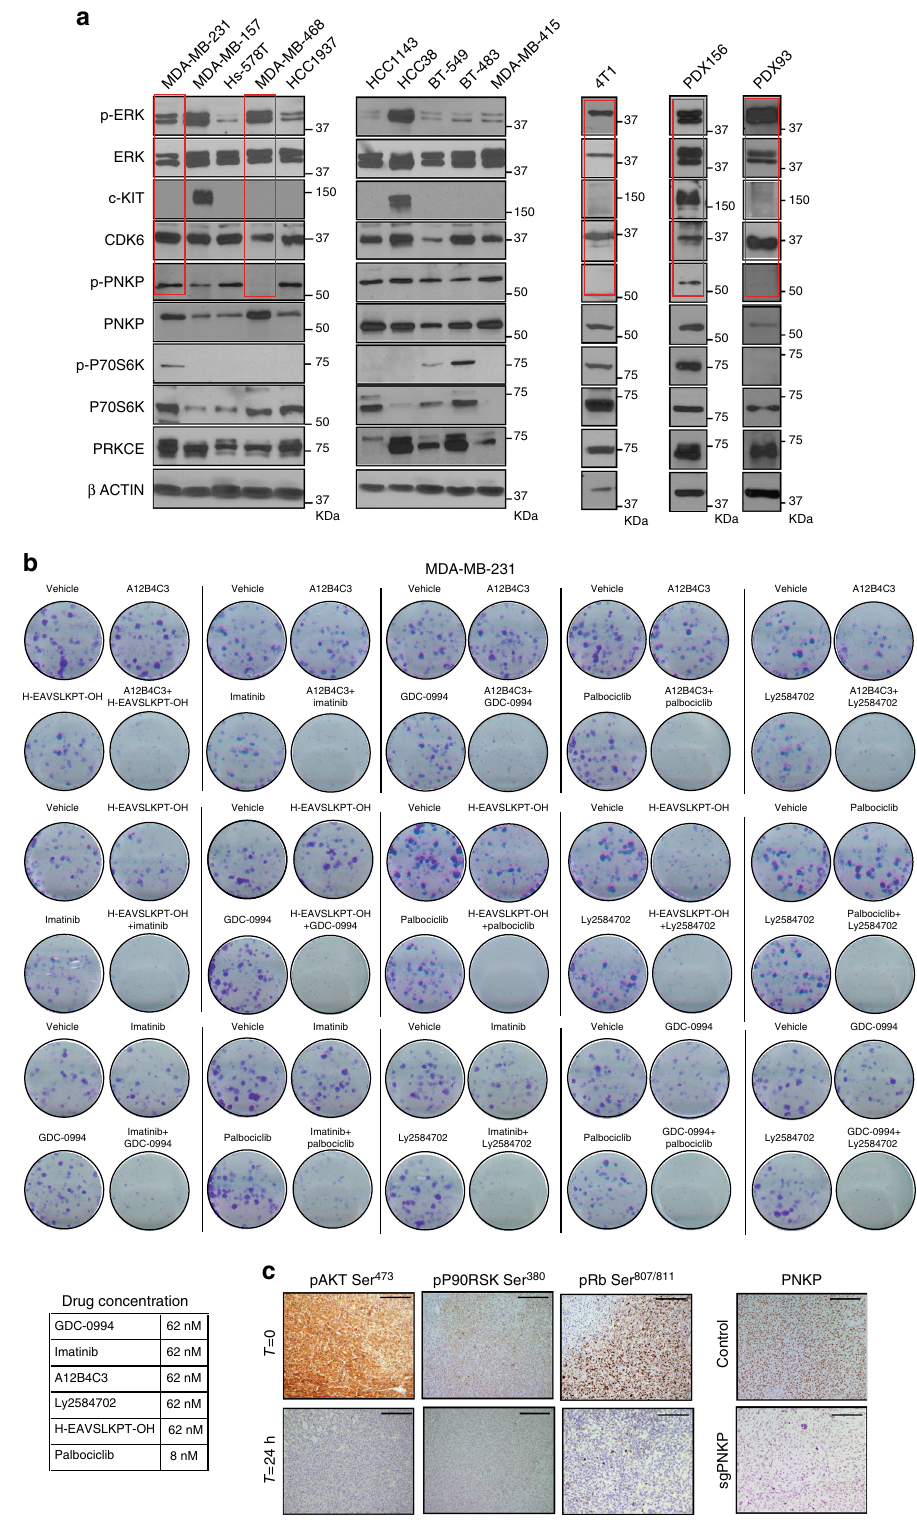
to each treatment alone. However, in PDX93, only palbociclib plus GDC-0994, but not the imatinib-based doublets, achieved statistically signi fi cant differences in tumor control (Supplemen- tary Figure 13B). Taken together, these data suggest that the levels of the kinases in K-high, which drive aggressive TNBC biology, appear to aid selection of active and relatively speci fi c doublets in TNBC preclinical